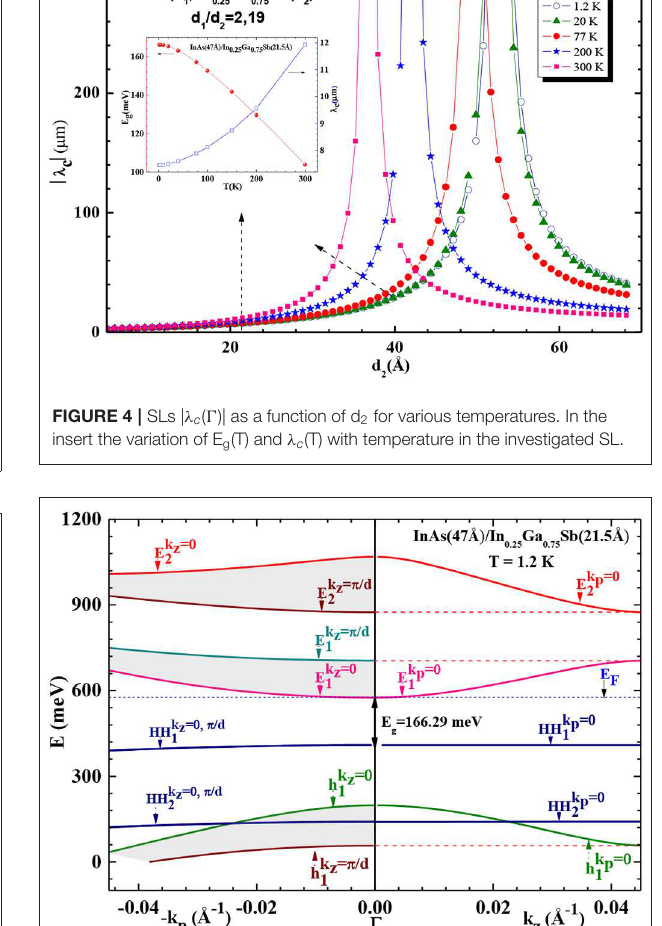
FIGURE 3 | Band gap, E g , as a function of the valence band offset at different temperatures in the investigated superlattice. The vertical dashed line indicates our chosen value of 510 meV.